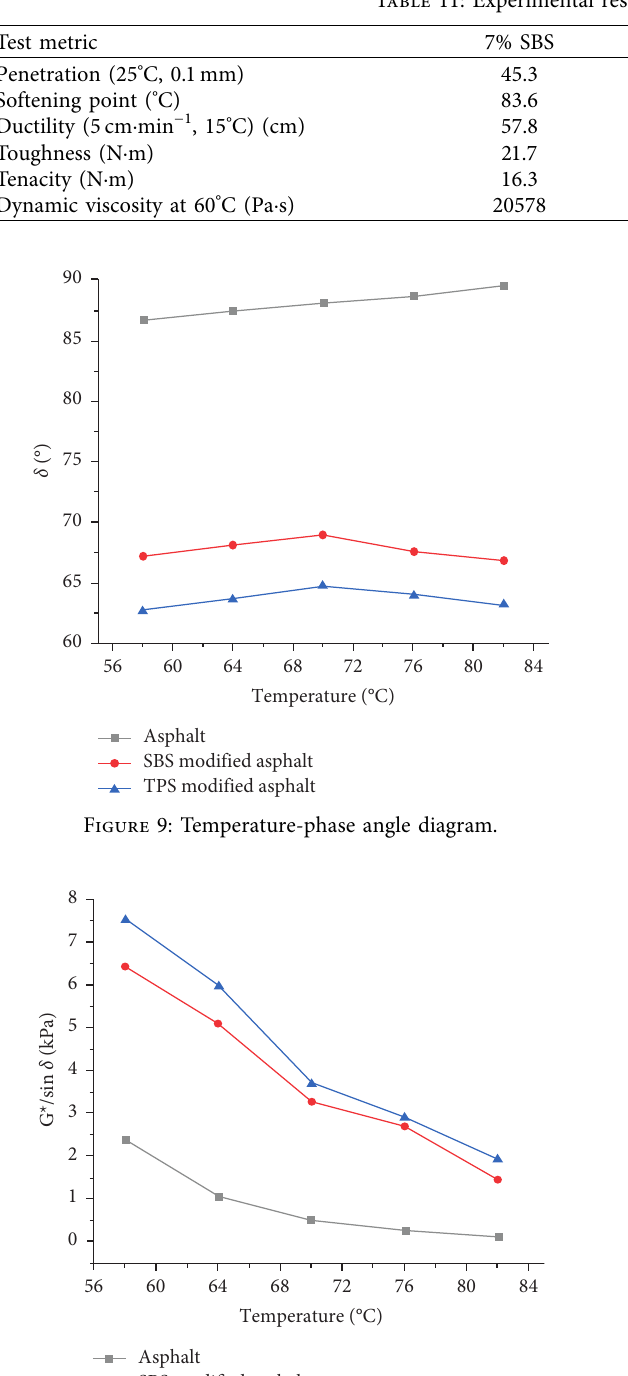
Figure 12: Relationship between creep rate and